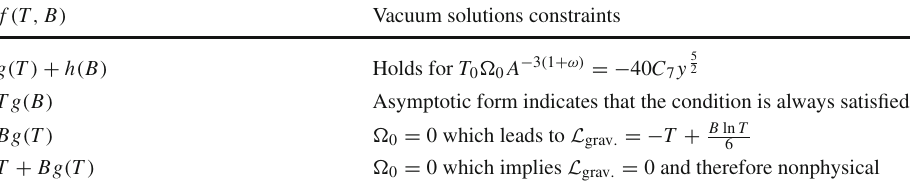
Table 8 A summary of the reconstructed Lagrangian solutions as well as their asymptotic forms close to the bounce point for the case of a mat- ter bounce cosmology. For simplicity, the variables x := 1 −